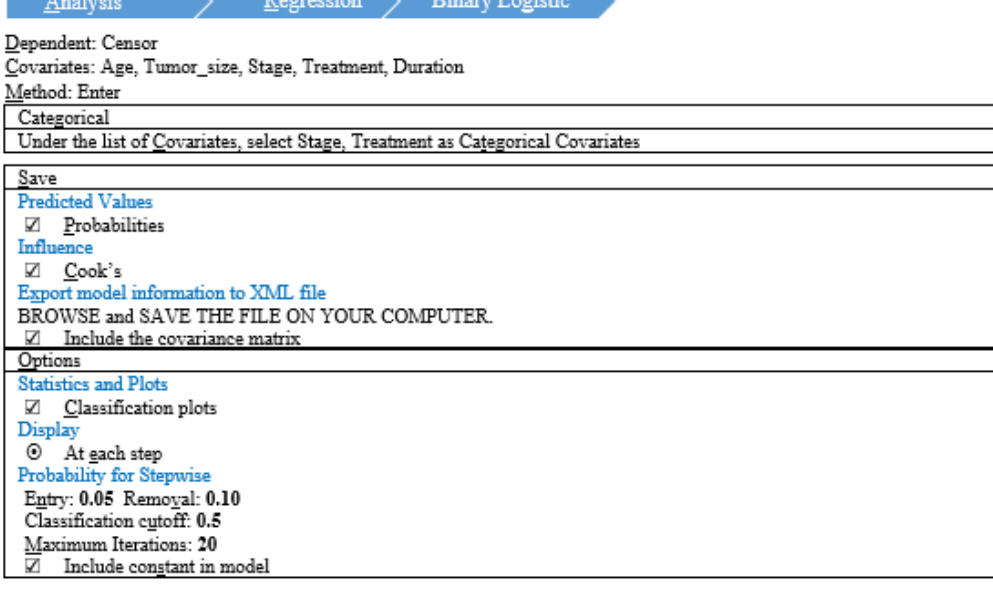
Figure 9. SPSS set up for Logistic Regression Models